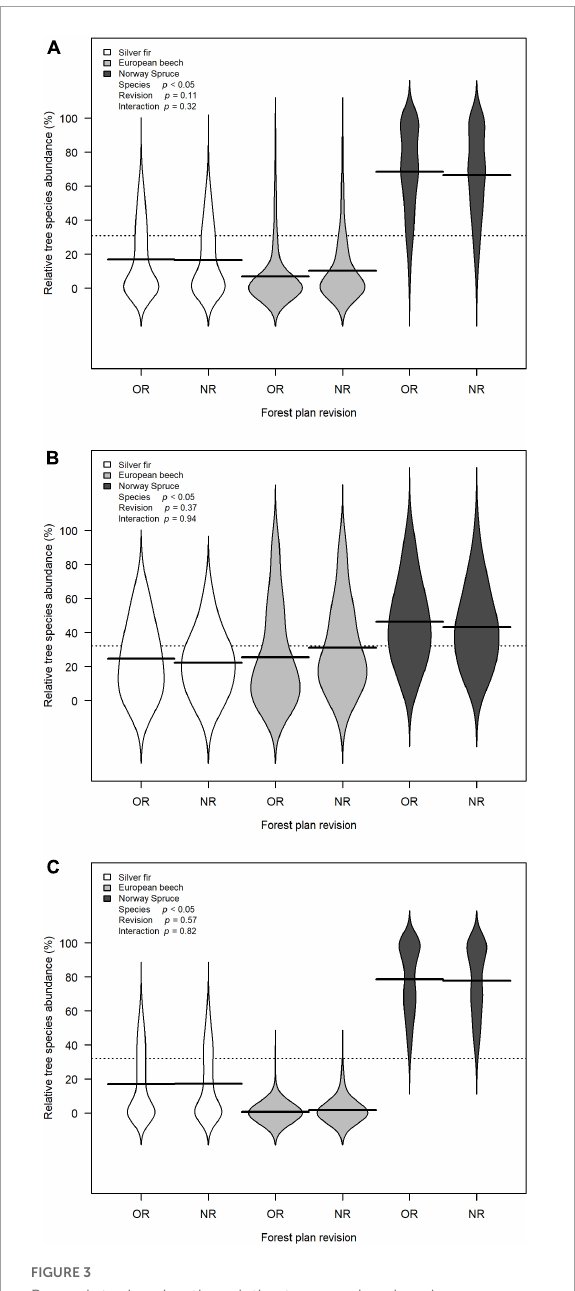
FIGURE3 Bean plots showing the relative tree species abundance distributions of the three most frequent species collected in forest management plans: silver fir, European beech, Norway spruce. Two relative tree species abundance distributions are depicted for each species: one for the old revision (OR) and one for the new revision (NR) of forest management plans. Black solid lines are the bean means, representing the mean of each relative tree species abundance distribution. Black dotted line is the overall mean. p -Values are from the F test for the zero-inflated general linear model to test the effect of the species, the forest plan revision, and their interaction. (A) Full database of forest compartments ( n = 331); (B) forest compartments dominated by 9130 forest habitat type ( n = 43); (C) forest compartments dominated by 9410 forest habitat type ( n =